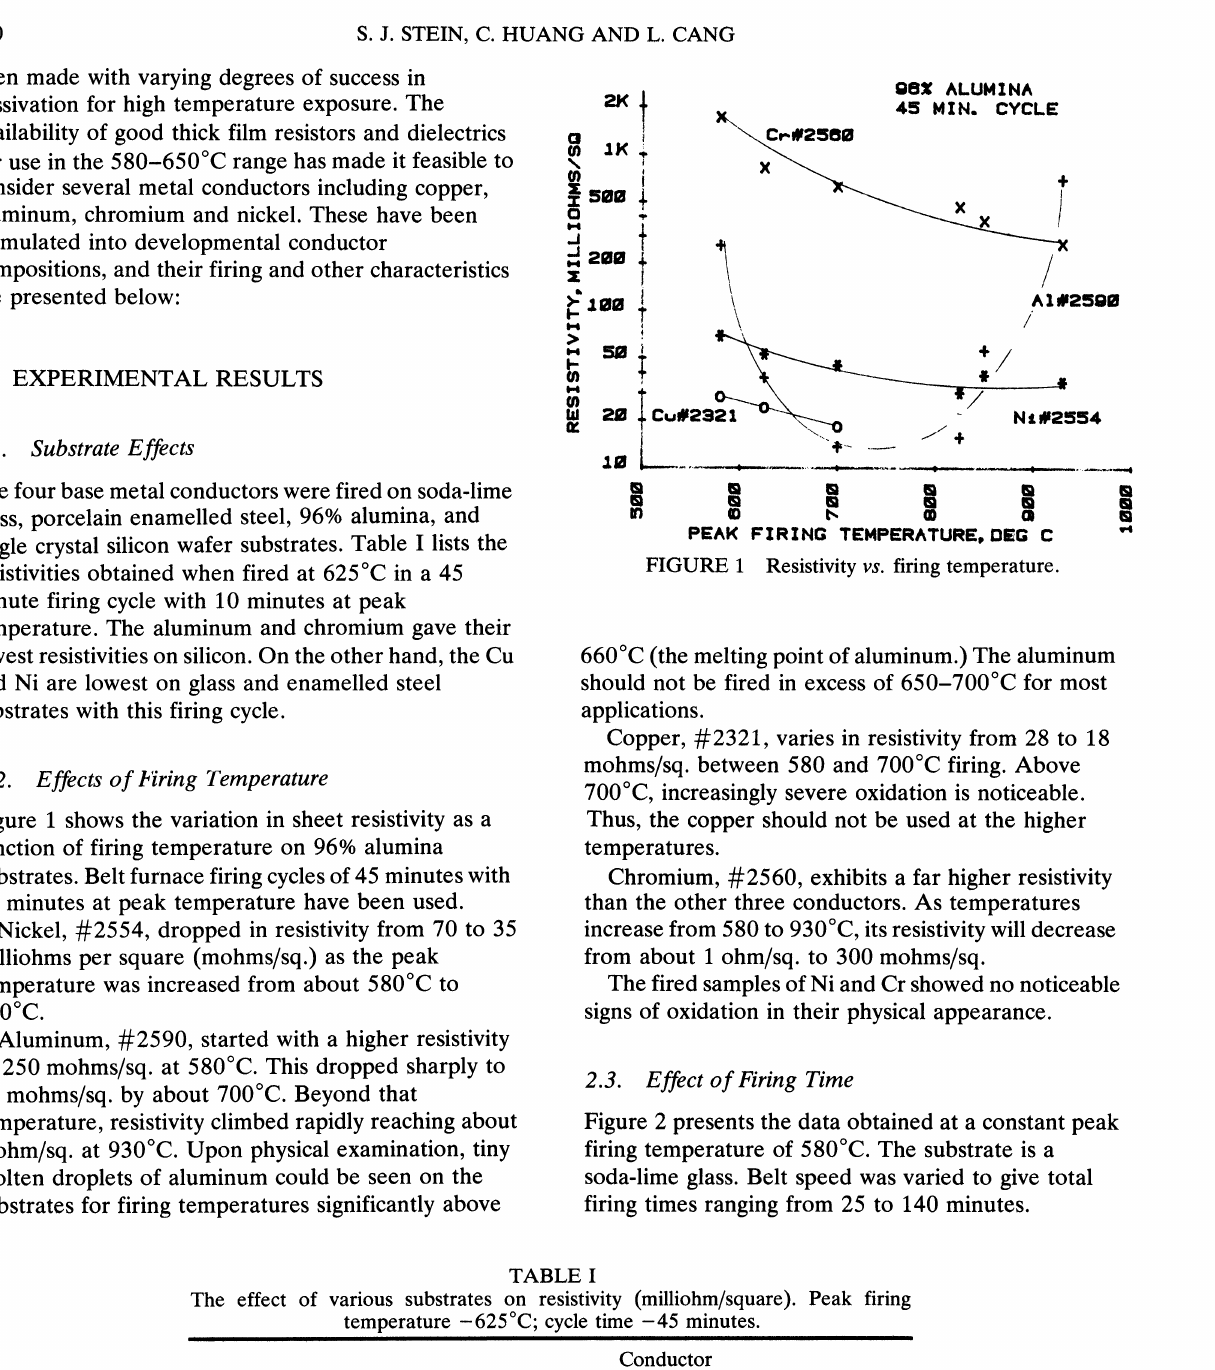
TABLE The effect of various substrates on resistivity (milliohm/square). Peak firing temperature -625C; cycle time -45